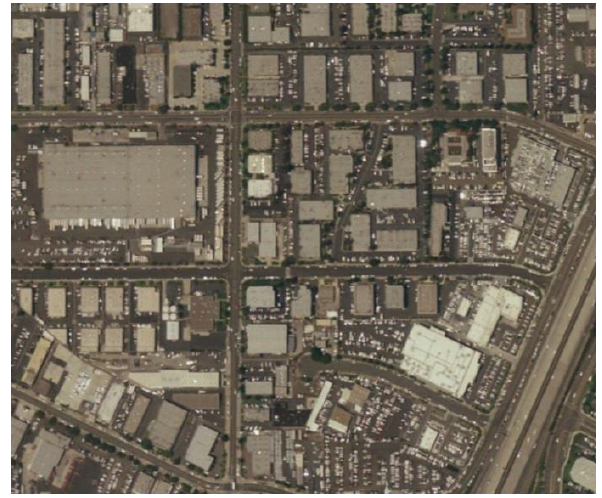
Figure 2. Ground truth image of the test